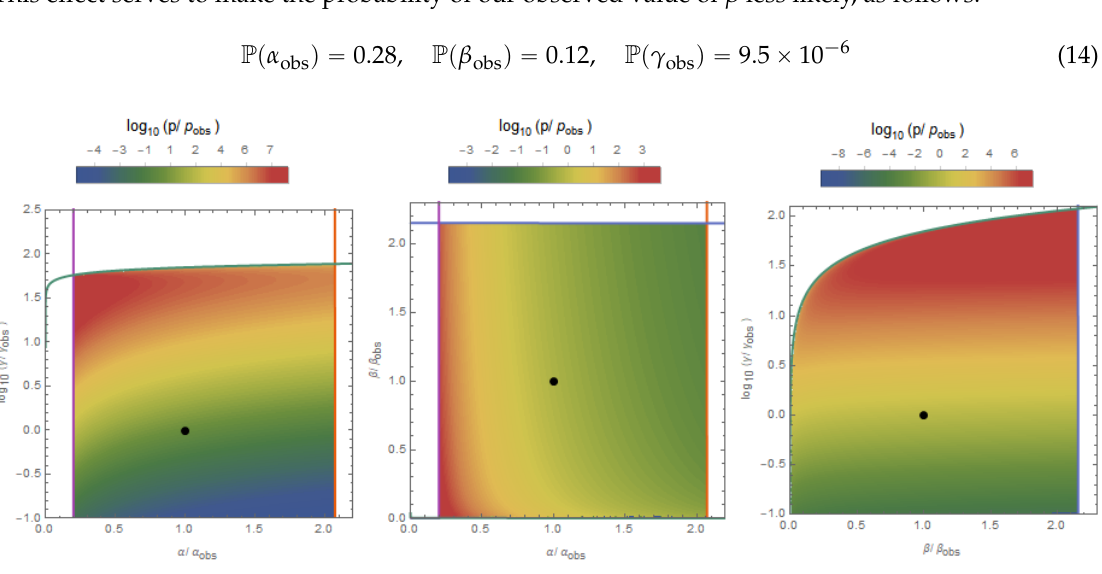
Figure 5. Distribution of observers from imposing the biological timescale condition. Of note is the secondary preference for large β the anthropic boundary